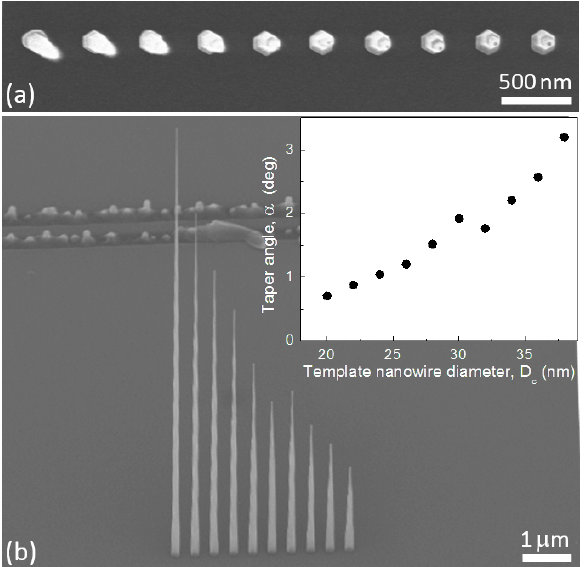
Figure 7. ( a ) Plan- and ( b ) 45 ◦ -view SEM images of a linear array of nanowires where the catalyst diameter, D c , and hence template nanowire diameter increases from 20nm (left) to 38nm (right) in 2nm increments. Inset in ( b ) shows the dependence of the taper angle α on D c